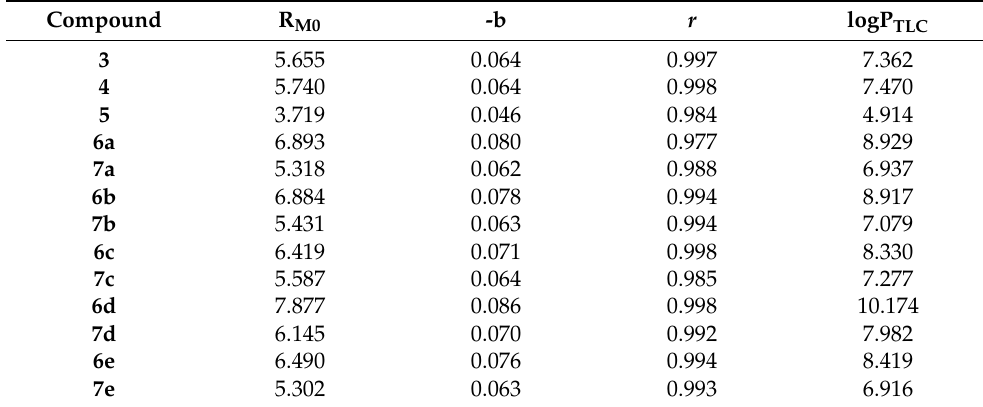
Table 6. The experimental values of lipophilicity for tested compounds 3 – 5 , 6a – 6e , and 7a – 7e . Compound R